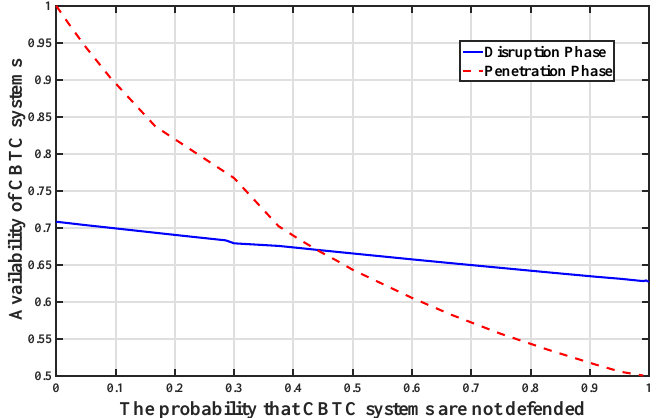
Figure 7. The defense scheme impact on CBTC availability.